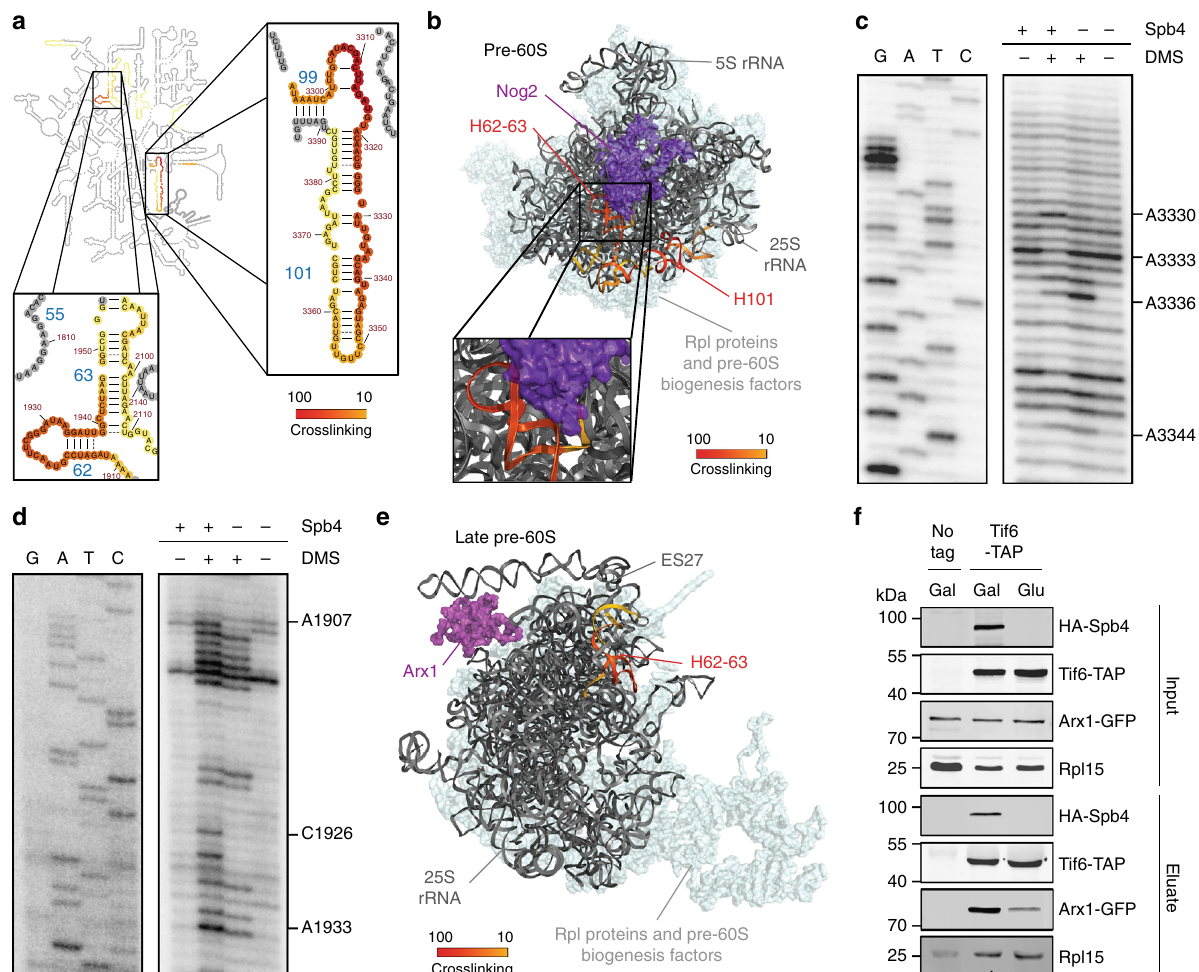
Fig. 6 Spb4 contacts H101 and H62 – 63 of the 25S rRNA sequence. a The number of sequence reads in the Spb4-HTP CRAC data corresponding to each nucleotide of the 25S rRNA sequence is shown on the secondary structure of the mature 25S rRNA using a colour code where the maximum of reads (100%) is shown in red and lower numbers of reads (10%) are shown in yellow. Magni fi ed views of the Spb4 crosslinking sites in H101 and H62 – 63 are presented. b The Spb4-HTP CRAC data was modelled onto the tertiary structure of the 25S rRNA sequence in a pre-60S complex puri fi ed via Nog2 (PDB: 3JCT [https://www.rcsb.org/structure/3JCT]) using a colour code as in ( a ). The position of Nog2 is indicated in purple. c , d Nop2-containing pre-60S complexes puri fi ed from yeast either expressing ( + ) or depleted ( − ) of Spb4 were immobilised on IgG sepharose and either treated with DMS ( + ) or left untreated ( − ). Isolated RNAs were used in primer extension reactions using primers hybridising downstream of H101 ( c ) or H62 – 63 ( d ). cDNA fragments were analysed by denaturing PAGE and visualised using a phosphorimager. Nucleotides that are differentially methylated by DMS in the presence and absence of Spb4 are indicated. Experiments were performed in replica and representative images are presented. e The Spb4 CRAC data was modelled onto the tertiary structure of the 25S rRNA sequence in a pre-60S complex puri fi ed via Rix1 (PDB: 5JCS [https://www.rcsb.org/structure/5JCS]) using a colour code as in (a). The position of Arx1 is indicated in purple. f Pre-60S complexes were isolated via TAP-tagged Tif6 from yeast expressing Arx1-GFP in the presence (Gal) or absence (Glu) of Spb4. Proteins in input and eluate samples were separated by SDS-PAGE and analysed by western blotting to